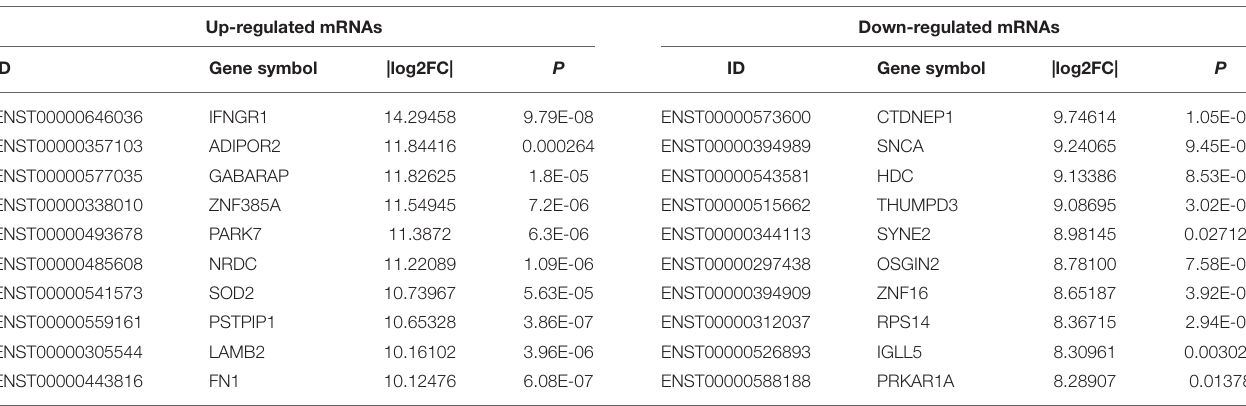
TABLE 1 | Top 10 of differently expressed mRNAs in HT and non-HT group (sorted by |log2FC|). Up-regulated mRNAs Down-regulated